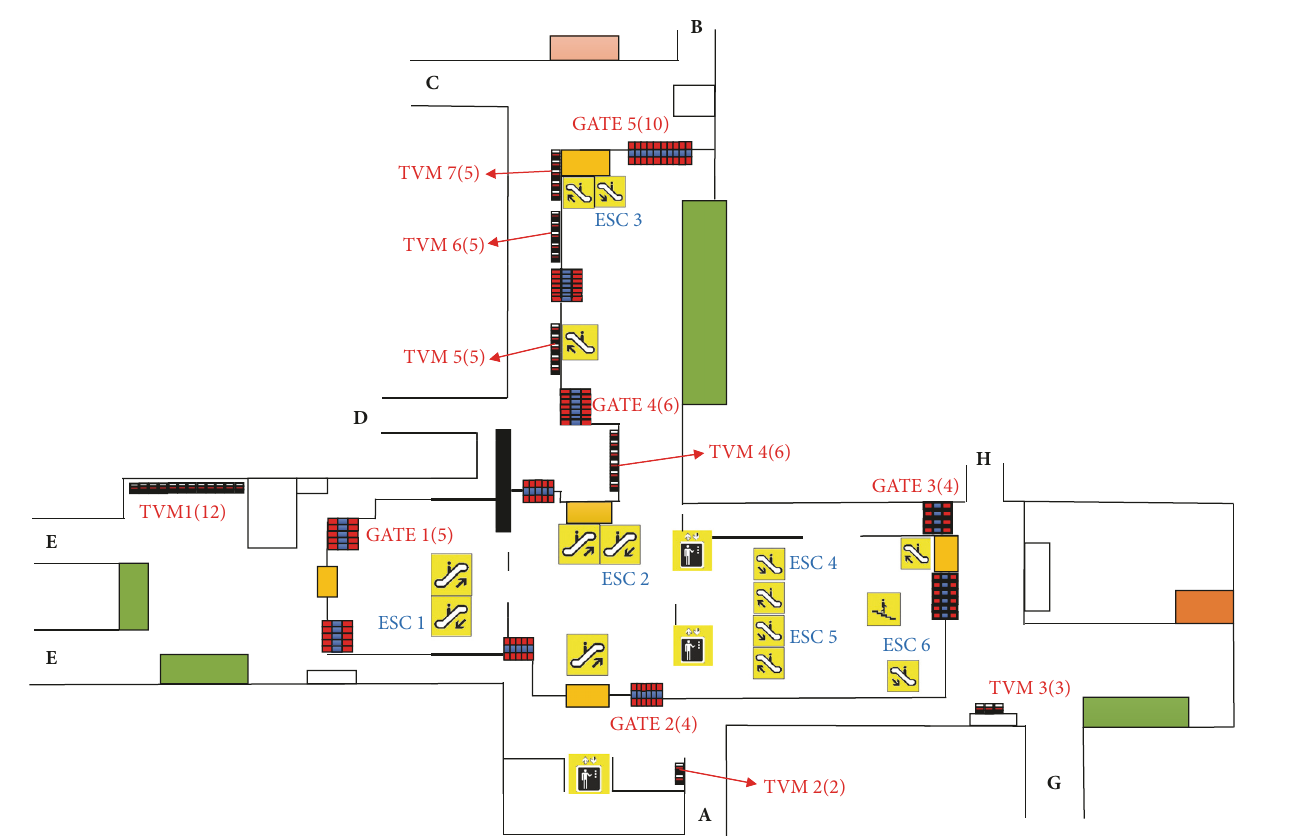
Figure 2: Sketch map of station hall layout of T